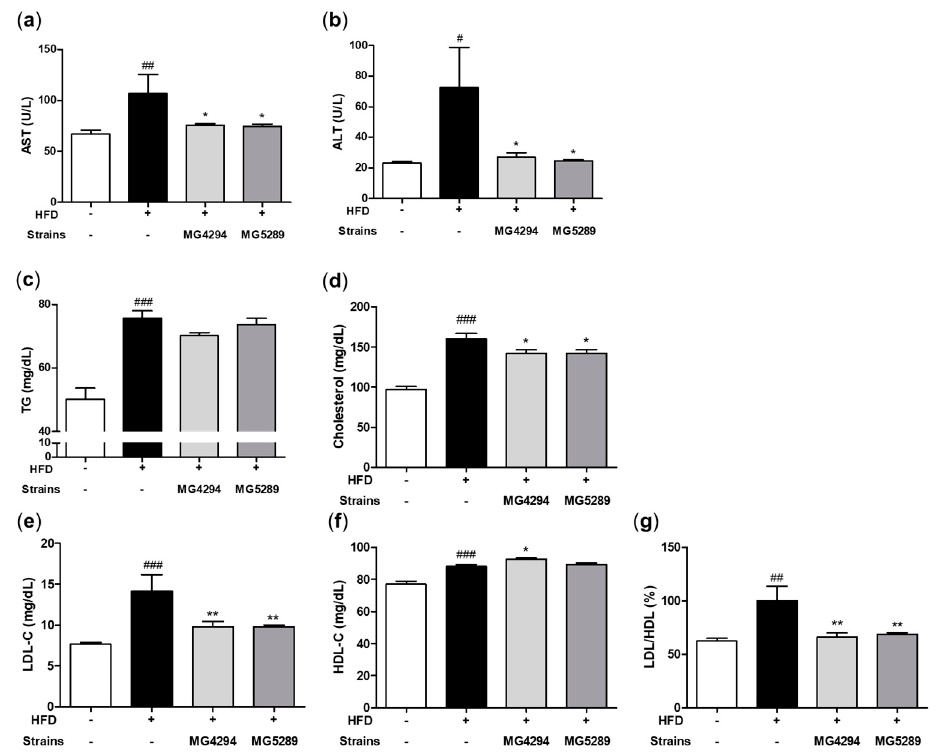
Figure 5. L. fermentum MG4294 and L. plantarum MG5289 improved AST ( a ), ALT ( b ), TG ( c ), TC ( d ), LDL-C ( e ), HDL-C ( f ), and LDL/HDL ( g ) in serum of HFD-induced mice. The data are expressed as mean ± SEM ( n = 6). # p < 0.05, ## p < 0.01 and ### p < 0.001 compared with ND group; * p < 0.05 and ** p < 0.01 compared with